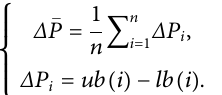
Frontiers in Energy Research |